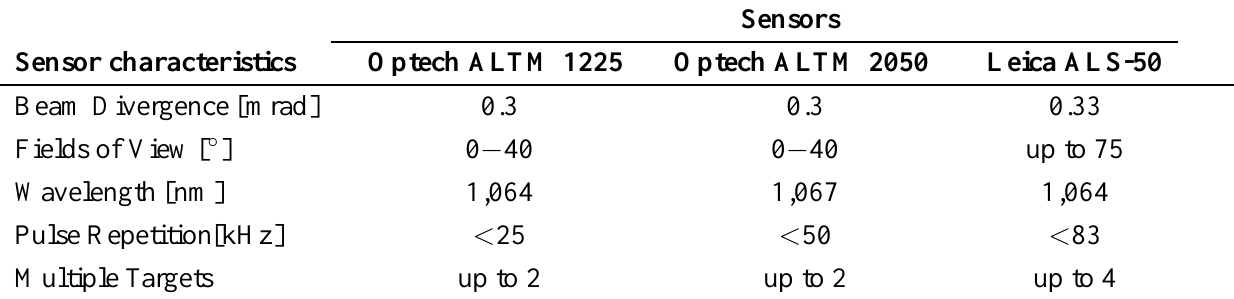
Table 1. Summary of characteristics of applied LiDAR